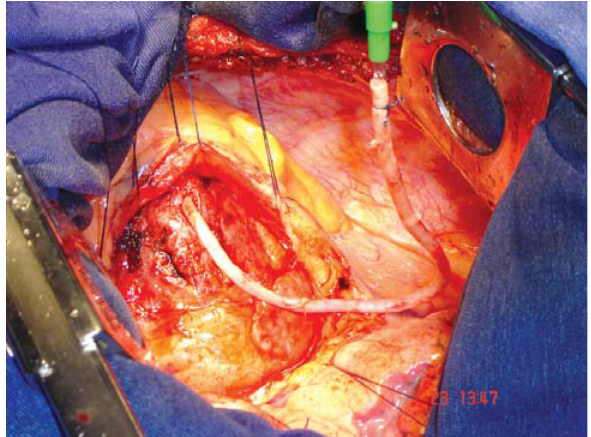
Fig. 4 - Anastomose distal da ponte de safena concluída